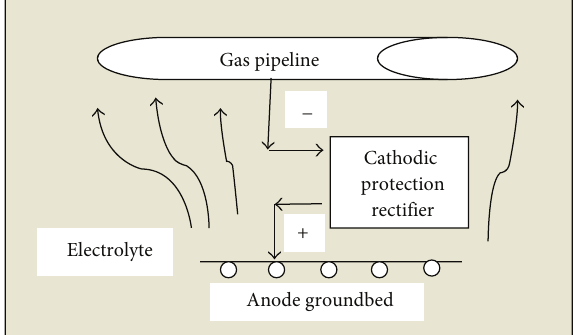
Figure 1: Schematic diagram of impressed current cathodic protec-